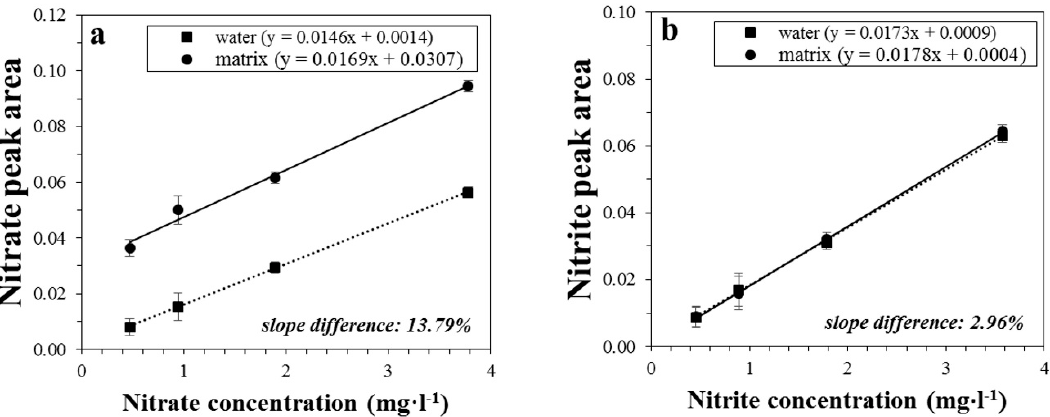
Figure 2. Calibration curves of nitrate ( a ) and nitrite ( b ) ions using standard solutions in water and a sample of homogenized chicken meat. Each point represents the mean of three replicated experiments ( n = 3), and the vertical bars represent the standard deviation (SD).